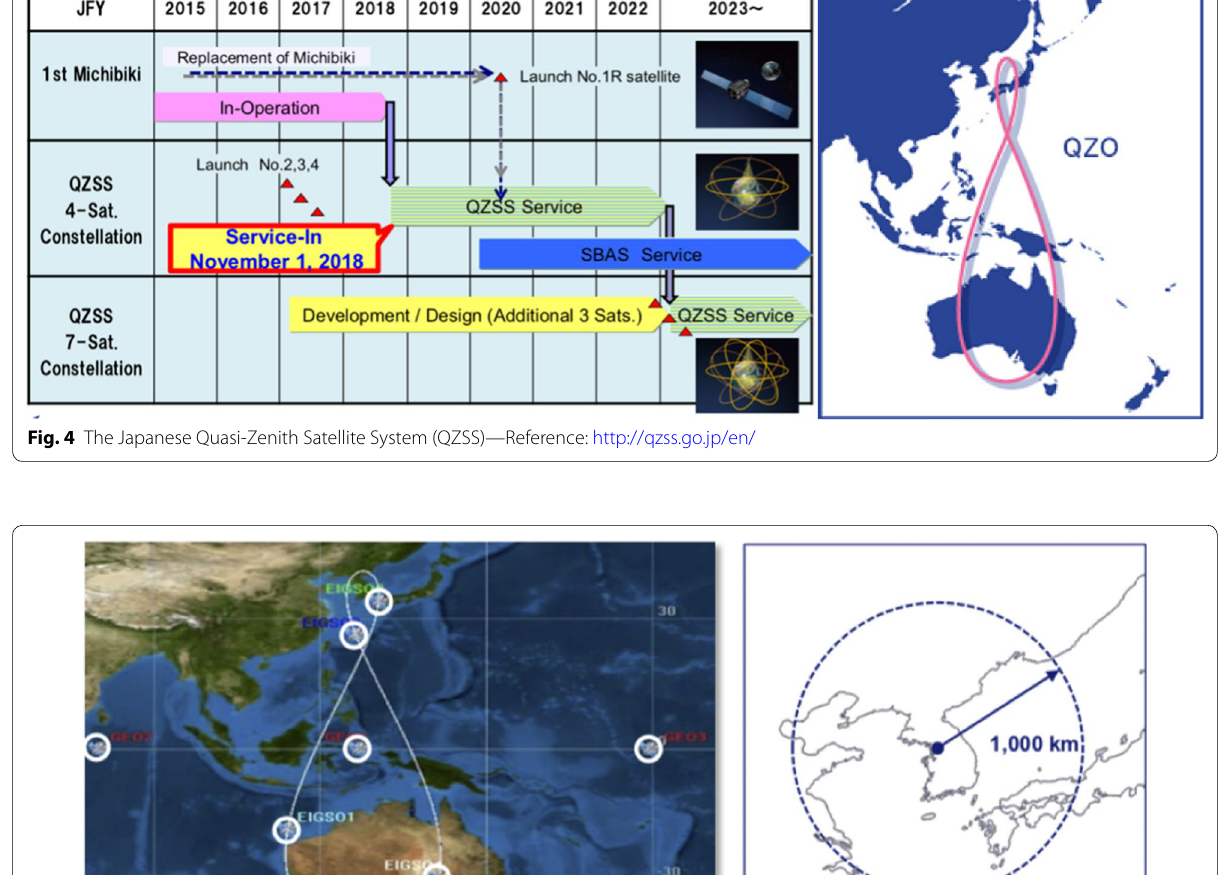
BeiDou Navigation Satellite System (BDS)